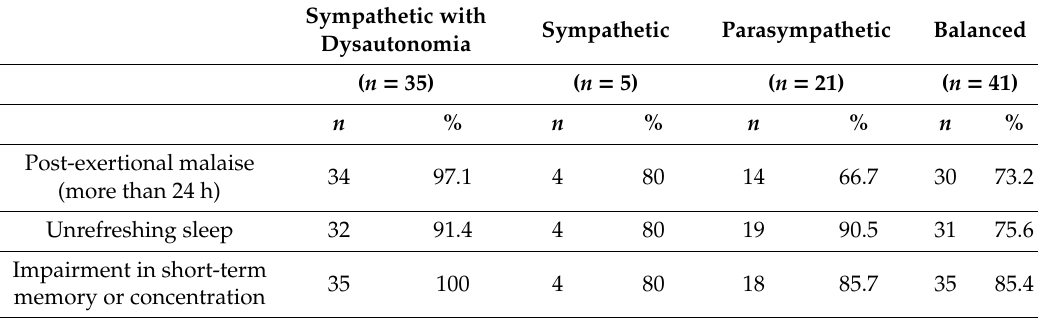
Table 7. Clinical characteristics of all the participants and of each profile according to the Fukuda